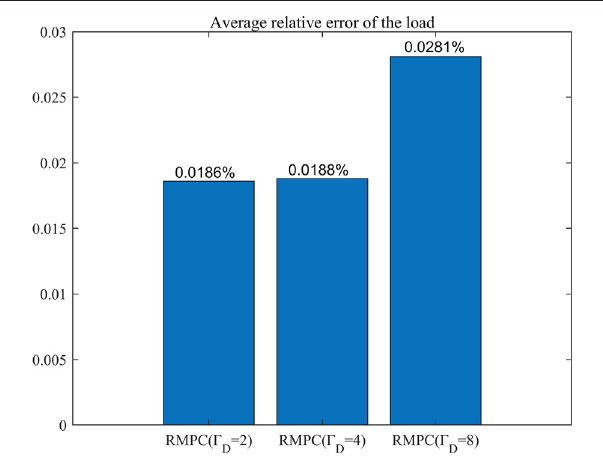
FIGURE 10 | Average relative error of the